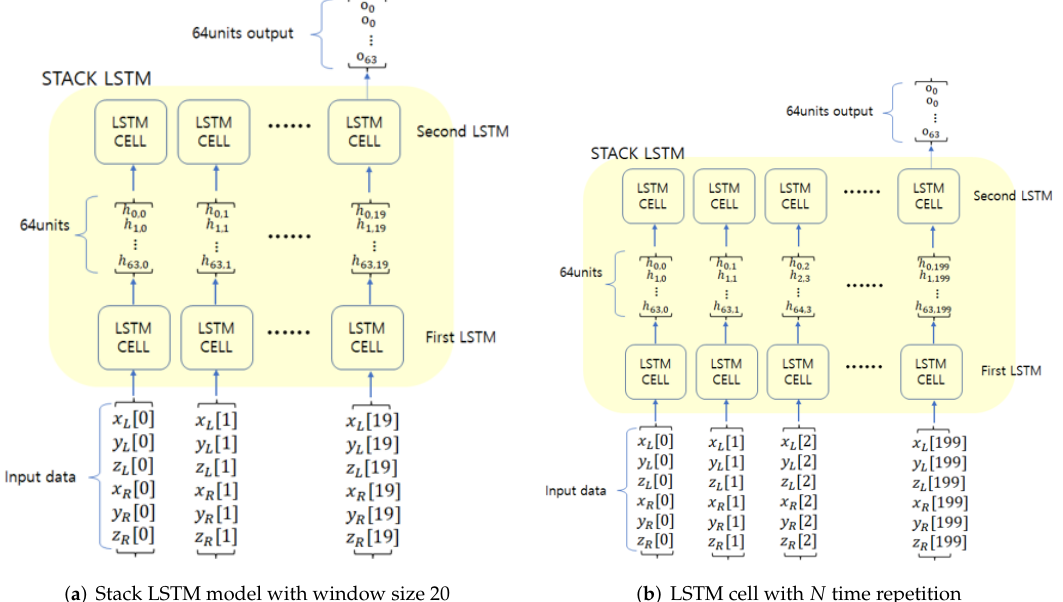
Figure 9. Stack LSTM model with window size 20 and